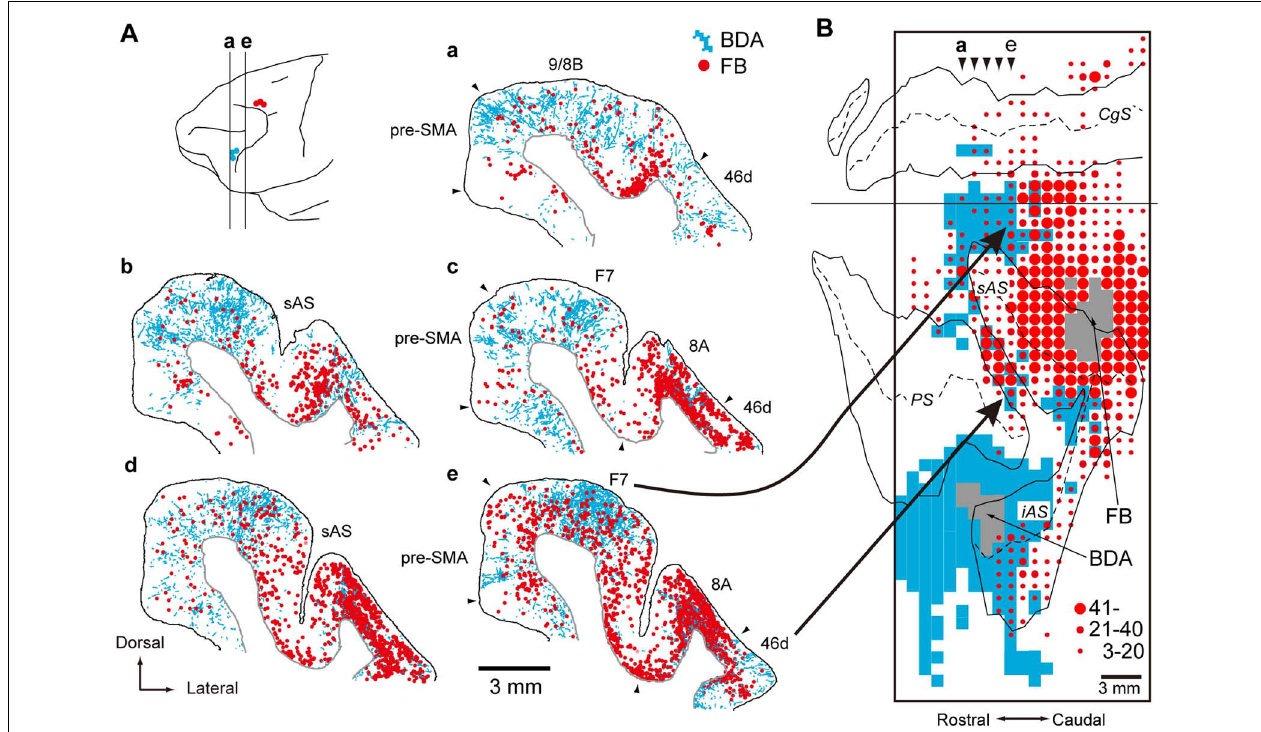
FIGURE 9 | Overlaps of axon terminals arising from the vlPFC and cell bodies projecting to the PMd in the frontal cortex. (A) Five representative coronal sections are arranged rostrocaudally.The approximate rostrocaudal levels of the sections (a–e) are indicated in the lateral view of the brain (with the sites of BDA and FB injections specified by blue and red circles, respectively). Labels in blue represent axon terminals labeled with BDA injected into vlPFC (area 45), and labels in red represent cell bodies labeled with FB injected into PMd. (B) A two-dimensional density map showing the distribution patterns of axon terminals labeled with BDA and cell bodies